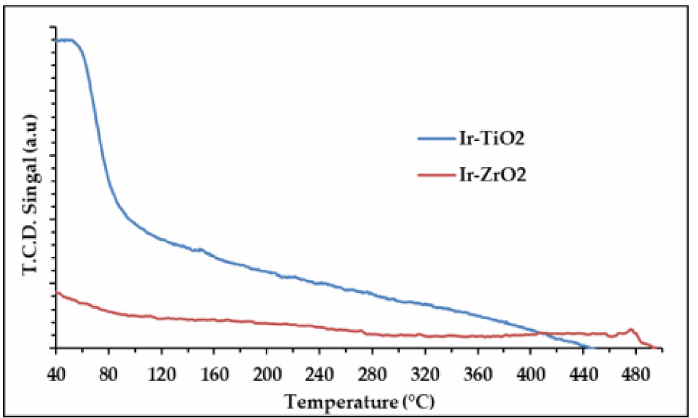
Figure 5. Temperature programmed oxidation (O 2 -TPO) profiles of the Ir-TiO 2 and Ir-ZrO 2